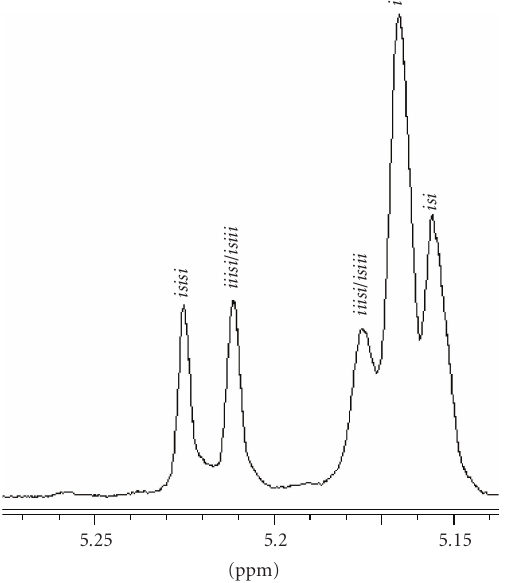
Figure 3: Homonuclear decoupled 1 H NMR spectrum of the methine region of PLDA obtained in Table 1, entry 1.